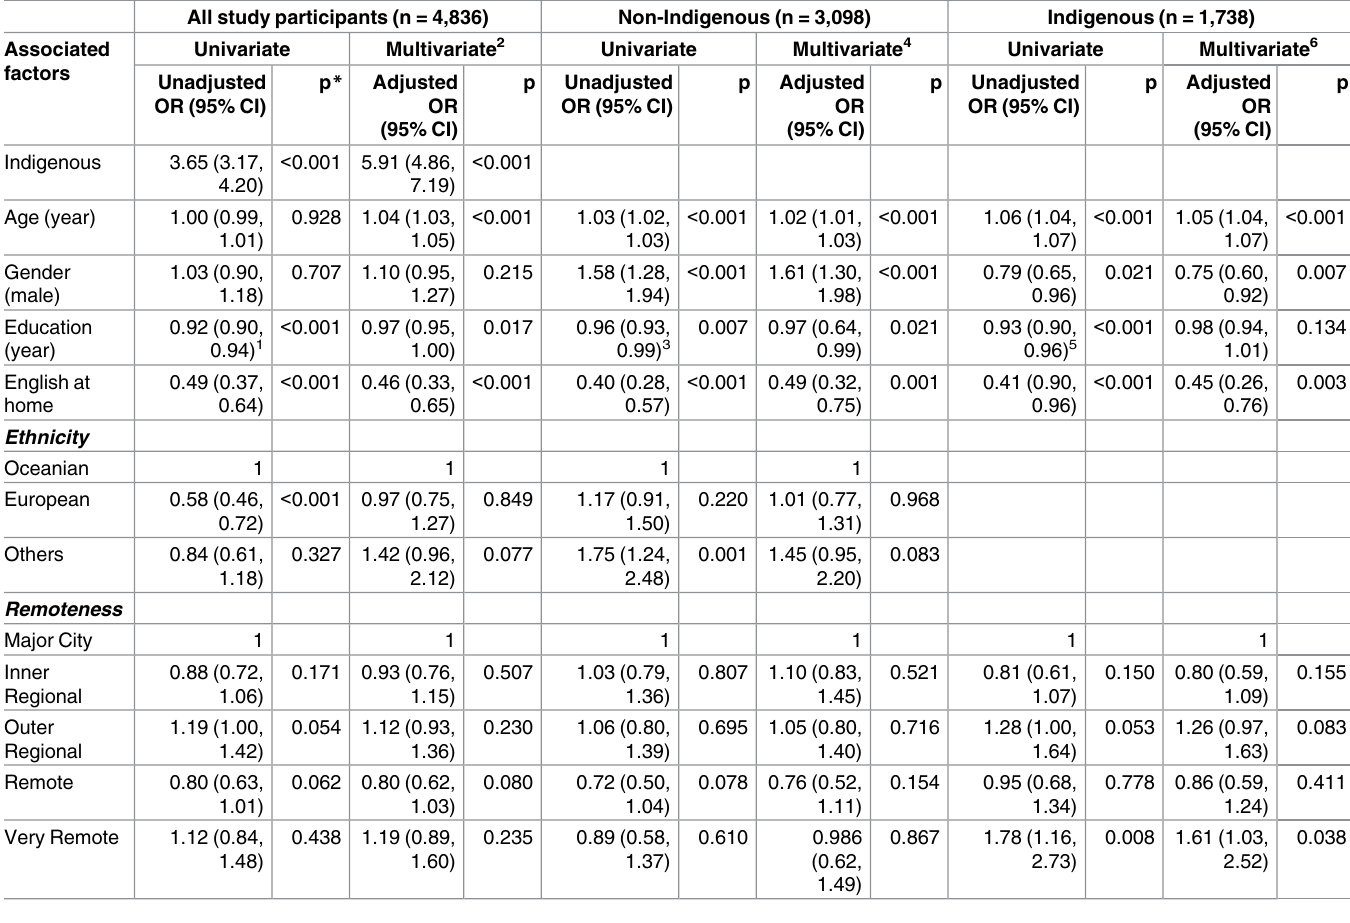
Table 2. Univariate and multivariable logistic regression analysis of associations between self-reported diabetes and sociodemographic factors. All study participants (n =